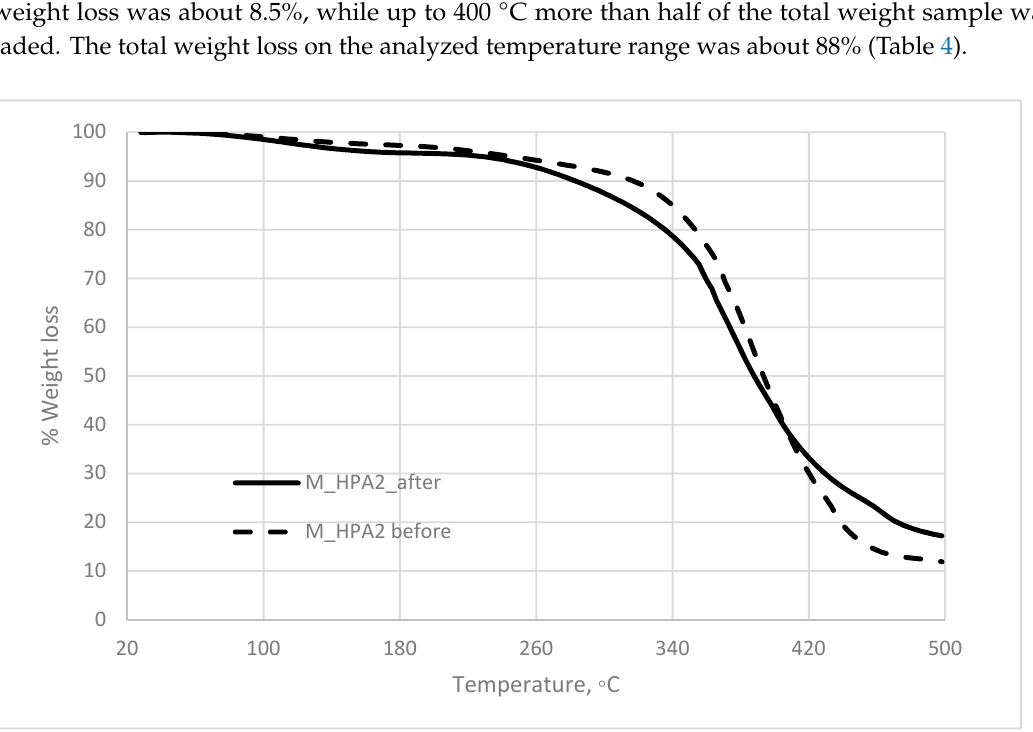
Figure 4. The thermogravimetrical (TG) diagram for the glycopolymer before and after biodegradation. Table 4. Weight loss of the glycopolymer before and after biodegradation.